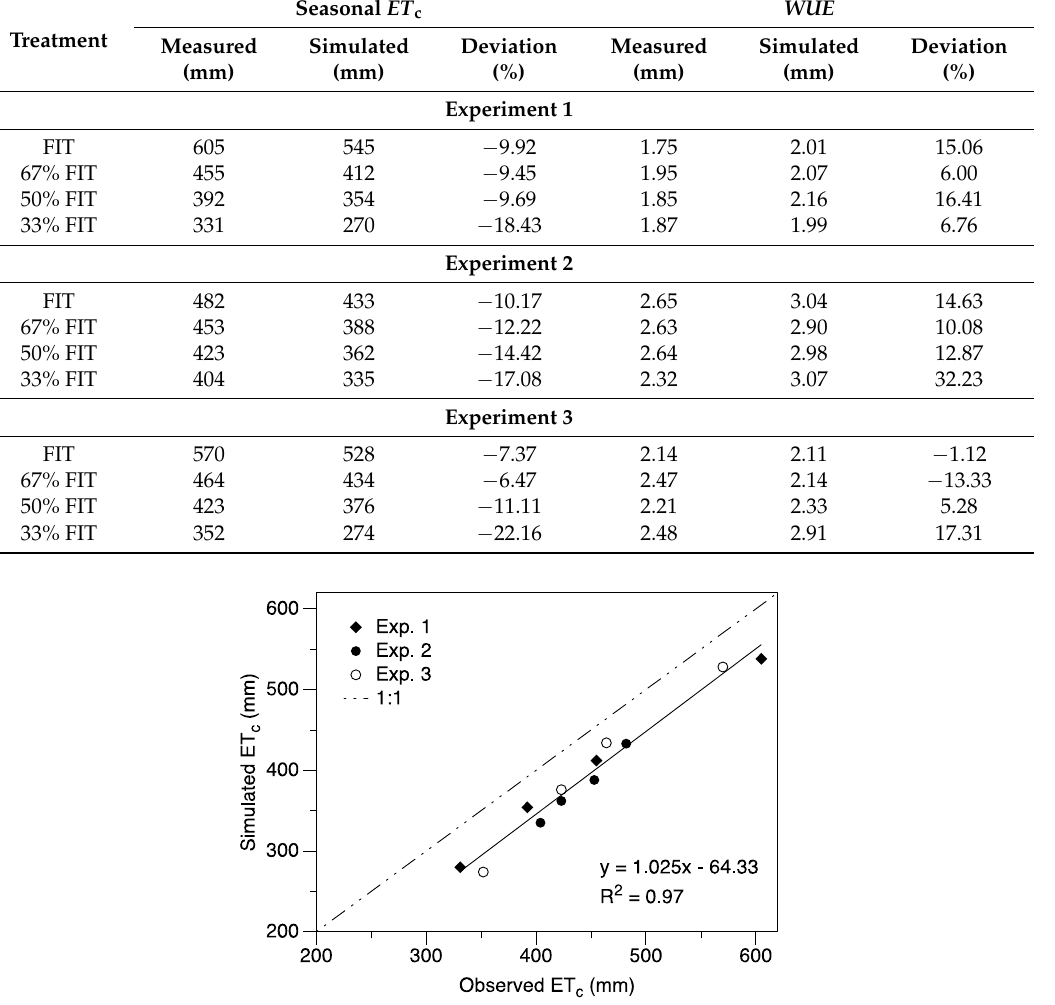
Figure 7. Comparison between measured and simulated seasonal evapotranspiration ( ET c ) for all treatments over the three experimental (Exp.) periods.